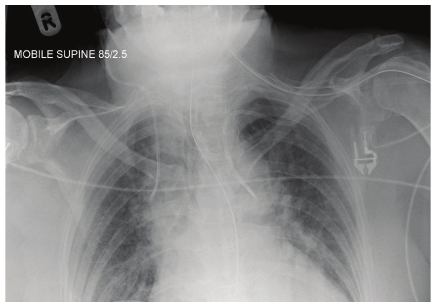
Figure 5: Chest radiograph showing abnormal position of the left subclavian line.